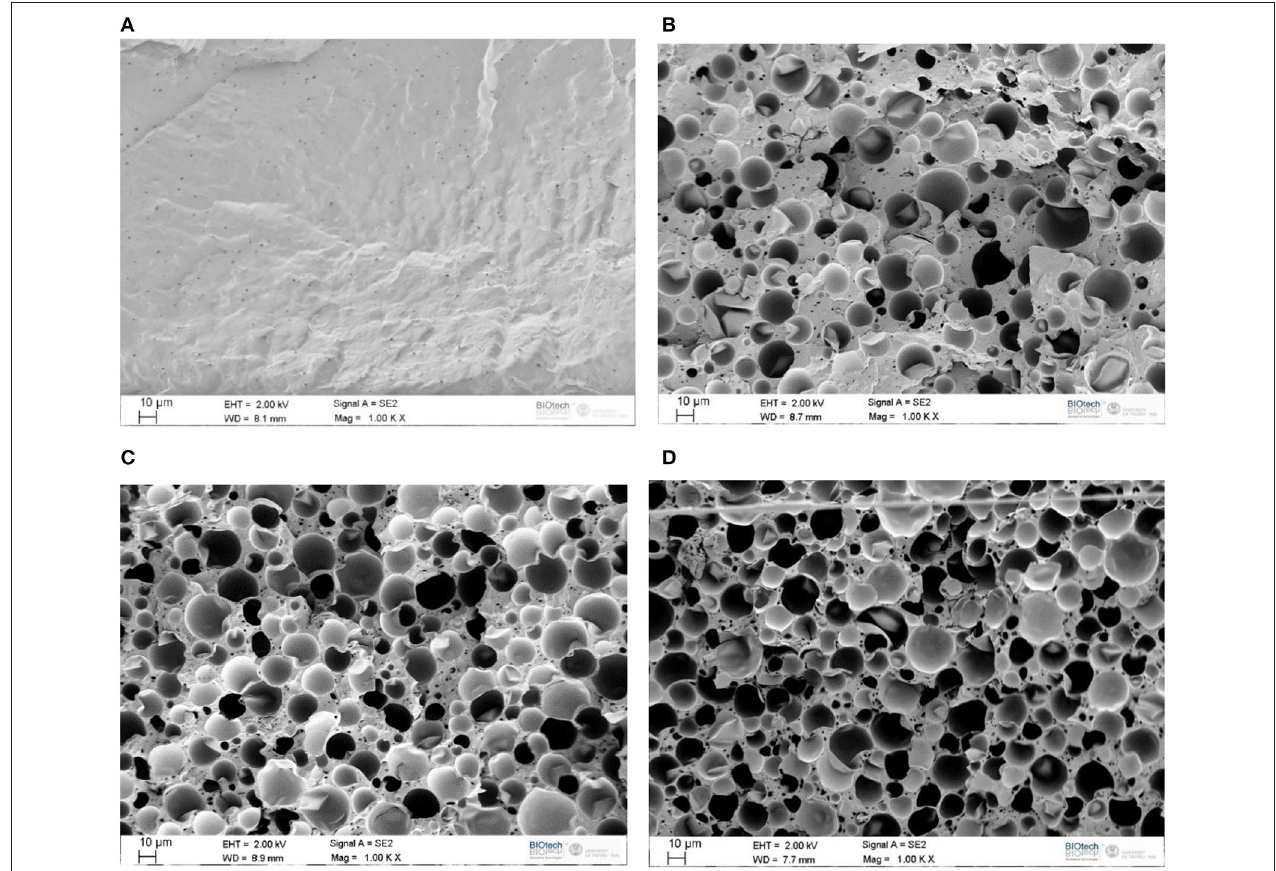
FIGURE 1 | FESEM micrographs of neat TPU and of the relative blends. (A) TPU, (B) TPU_30M6D, (C) TPU_50M6D, (D)